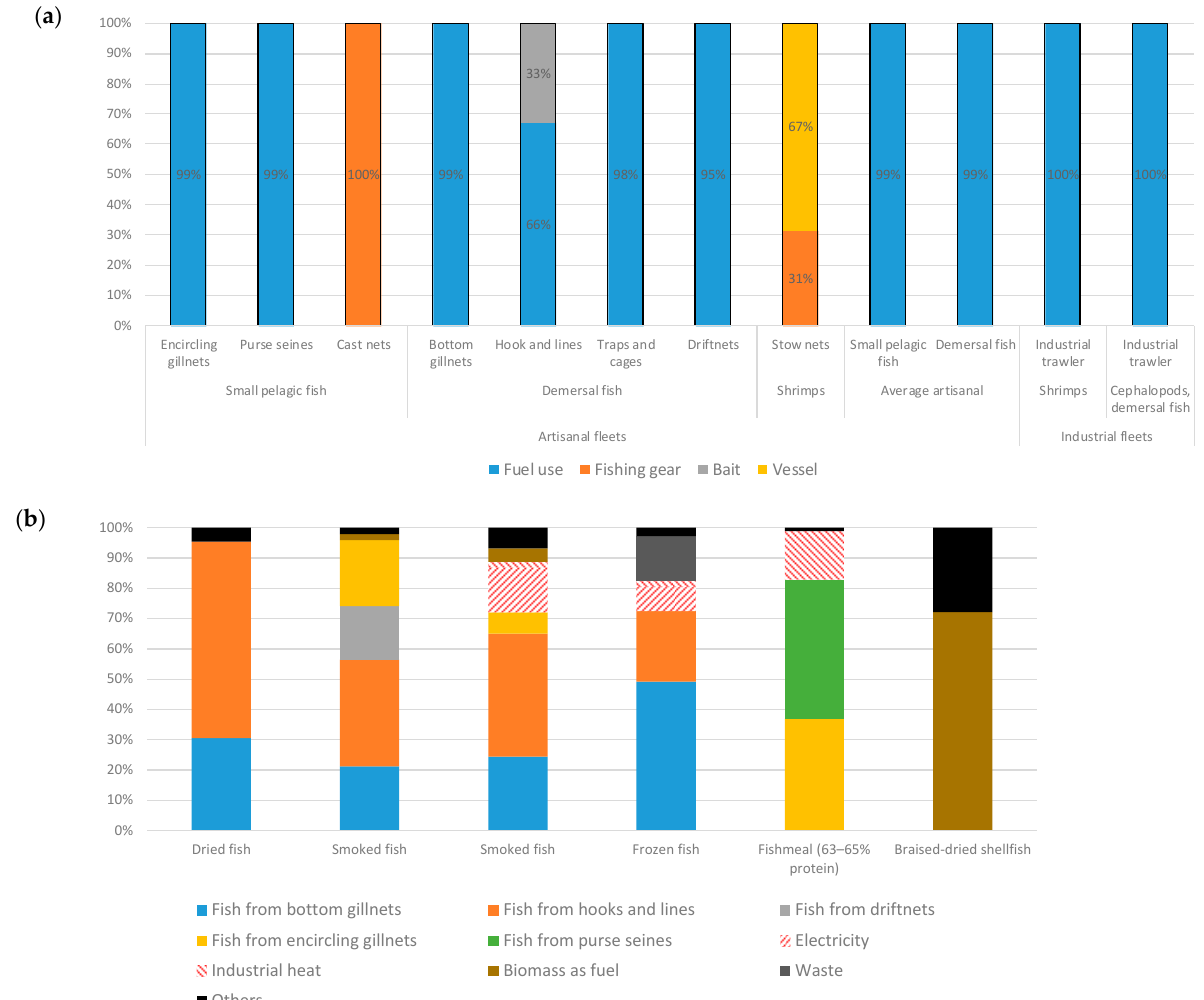
Figure 3. Contribution analysis of Gambian fish products per t of product and relative to the single scores of ( a ) fresh fish products and ( b ) processed fish